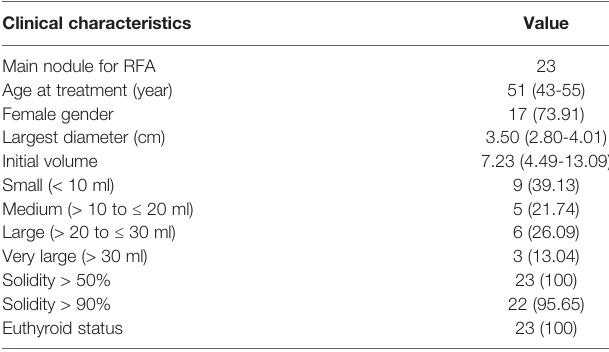
TABLE 1 | Baseline characteristics in 23 patients with thyroid radiofrequency